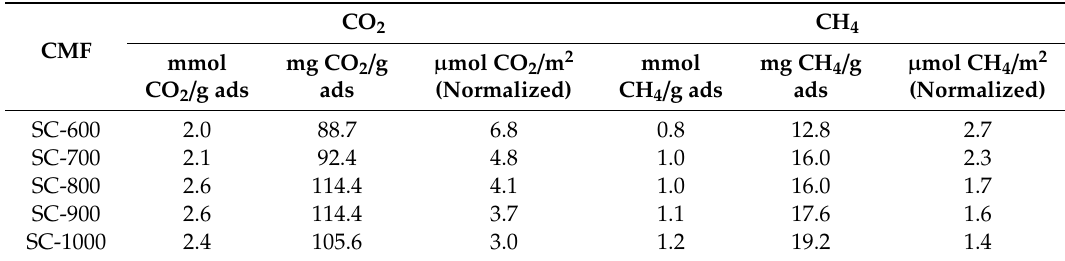
Table 4. CO 2 and CH 4 adsorption capacity (1 bar, 25 ◦ C) in materials carbonized at 600, 700, 800, 900, and 1000 ◦ C. g ads—gram of adsorbent of CMF.